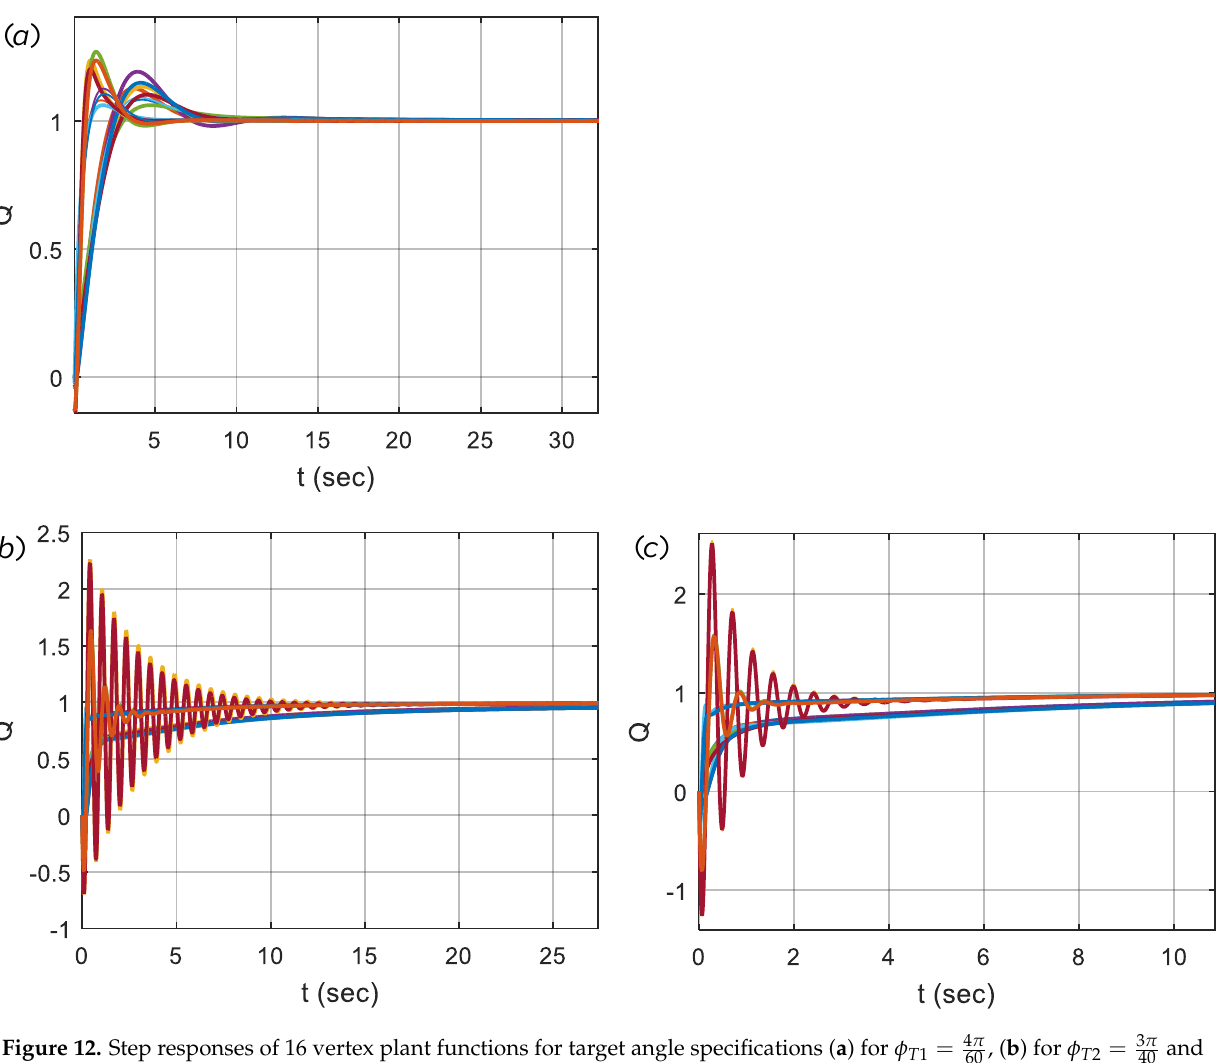
Table 4. MSE values of step responses for nominal plant functions